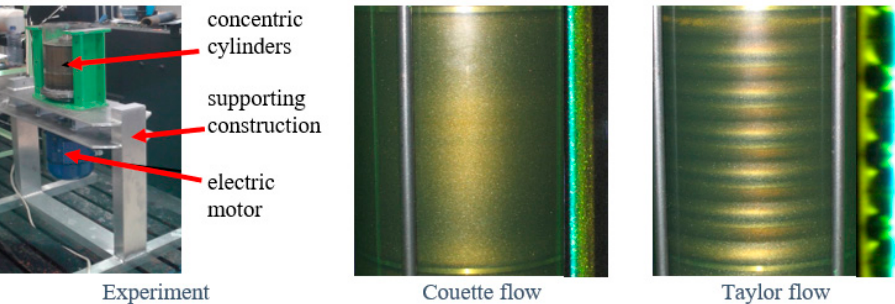
Figure 2. Flow between concentric cylinders during rotation of the inner cylinder, experiment and photos of the Couette and Taylor flow [15].